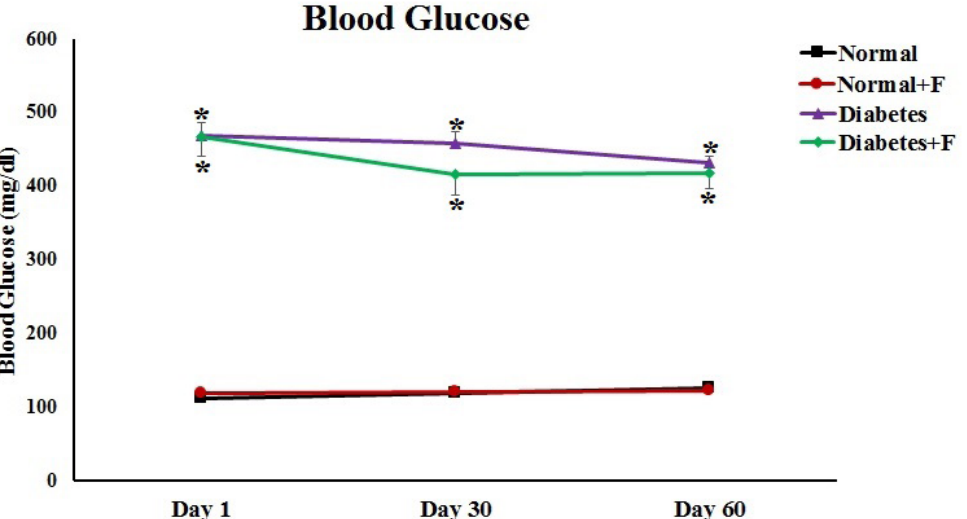
FIGURE 1 - Effects of fullerene on serum glucose level on days 1, 30, and 60 after STZ injection. Differences in measured parameters among 4 groups analyzed by using One-way ANOVA, followed by the Tukey post hoc test. All the data were presented as mean ± standard deviation of the mean. The symbol * denote significant differences with the normal group; *P<0.05. F: